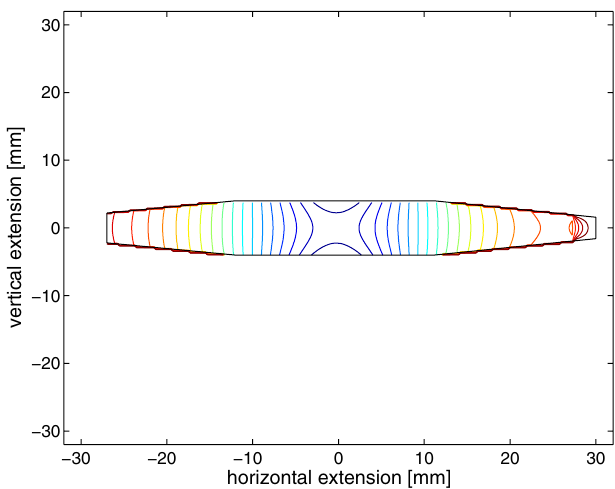
(cid:3) x; y (cid:4) at the middle l (cid:3) x; y (cid:4) has a l